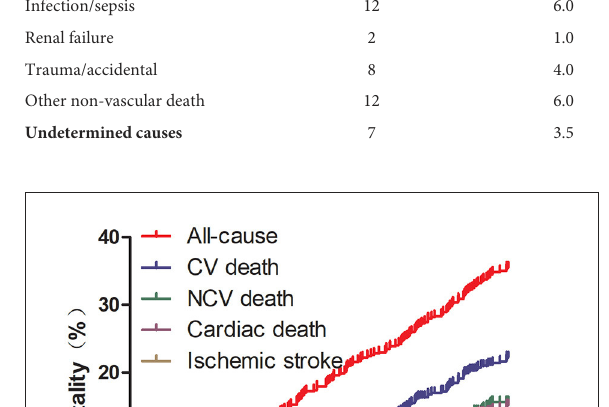
(Figure 3). The rate of anticoagulation was 28.5%. Of patients who received anticoagulants, warfarin was prescribed in 83.3% and non-vitamin K antagonist oral anticoagulants (NOAC) in 16.7% (dabigatran in 6.9% and rivaroxaban in